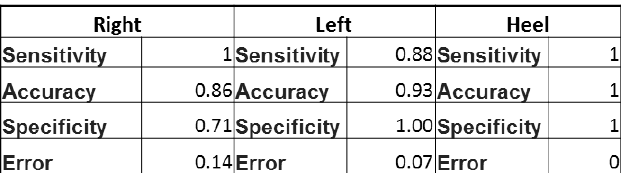
Table 7. Statistical data of confusion matrix for the pressure sensors.